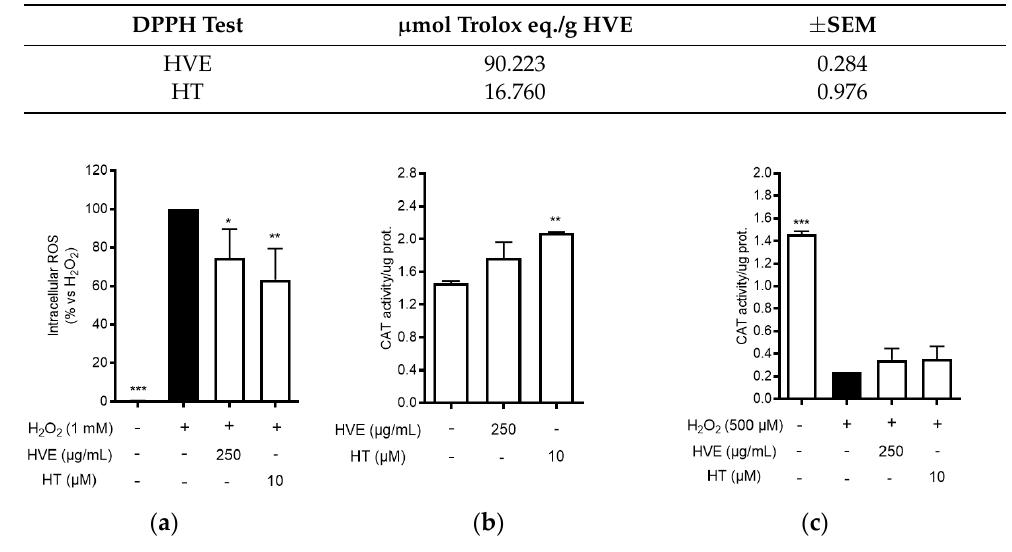
Figure 1. Effect of HVE (250 μg/mL) and HT (10 μM) on oxidative stress induced by H 2 O 2 in HaCaT cells. ( a ) Effect of HVE and HT pre-treatment (24 h) on intracellular ROS levels after 1 h of stimulation with H 2 O 2 (1 mM). Trolox (500 μM) and apigenin (20 μM), representing reference antioxidant compounds, inhibited ROS production by − 49% and − 37%, respectively. ( b ) Effect of HVE and HT treatment along with H 2 O 2 (500 μM) (24 h) on catalase activity; * p < 0.05, ** p < 0.01, *** p < 0.001 vs. stimulus. ( c ) Effect of HVE and HT on basal CAT activity; ** p < 0.01, vs. CTRL.